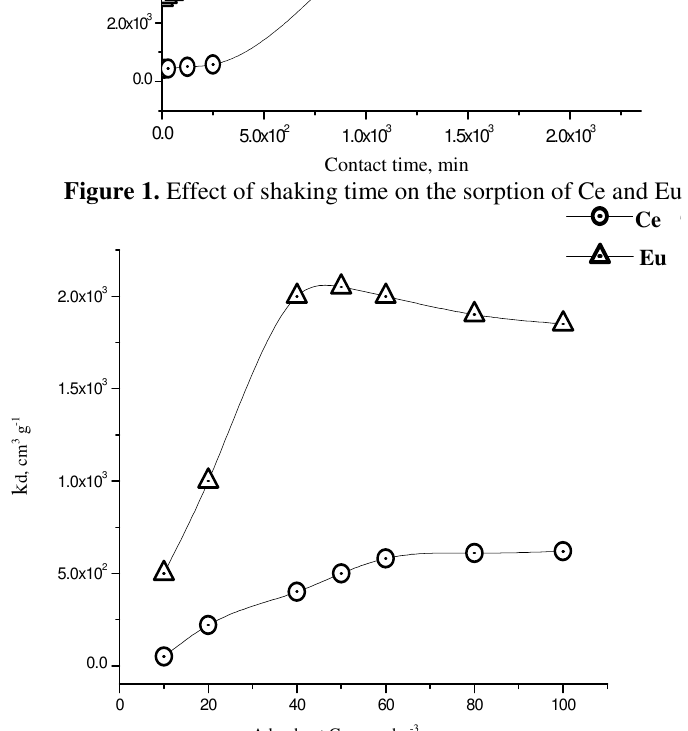
Figure 2. Variation of K